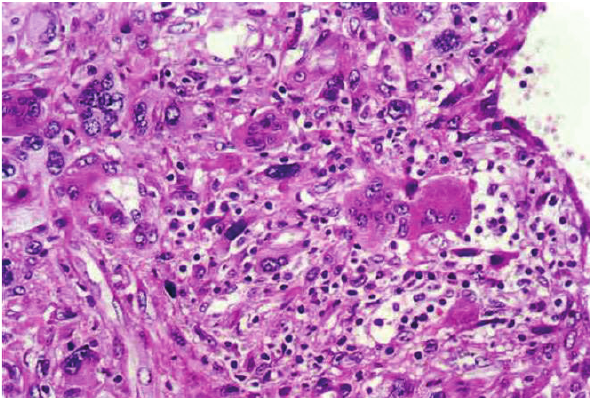
Figure 5 - Atypical osteoblastoma. High cellularity and atypical cells. No evidence of osteoid production (Case 27, hematoxylin-eosin stain, X 400)